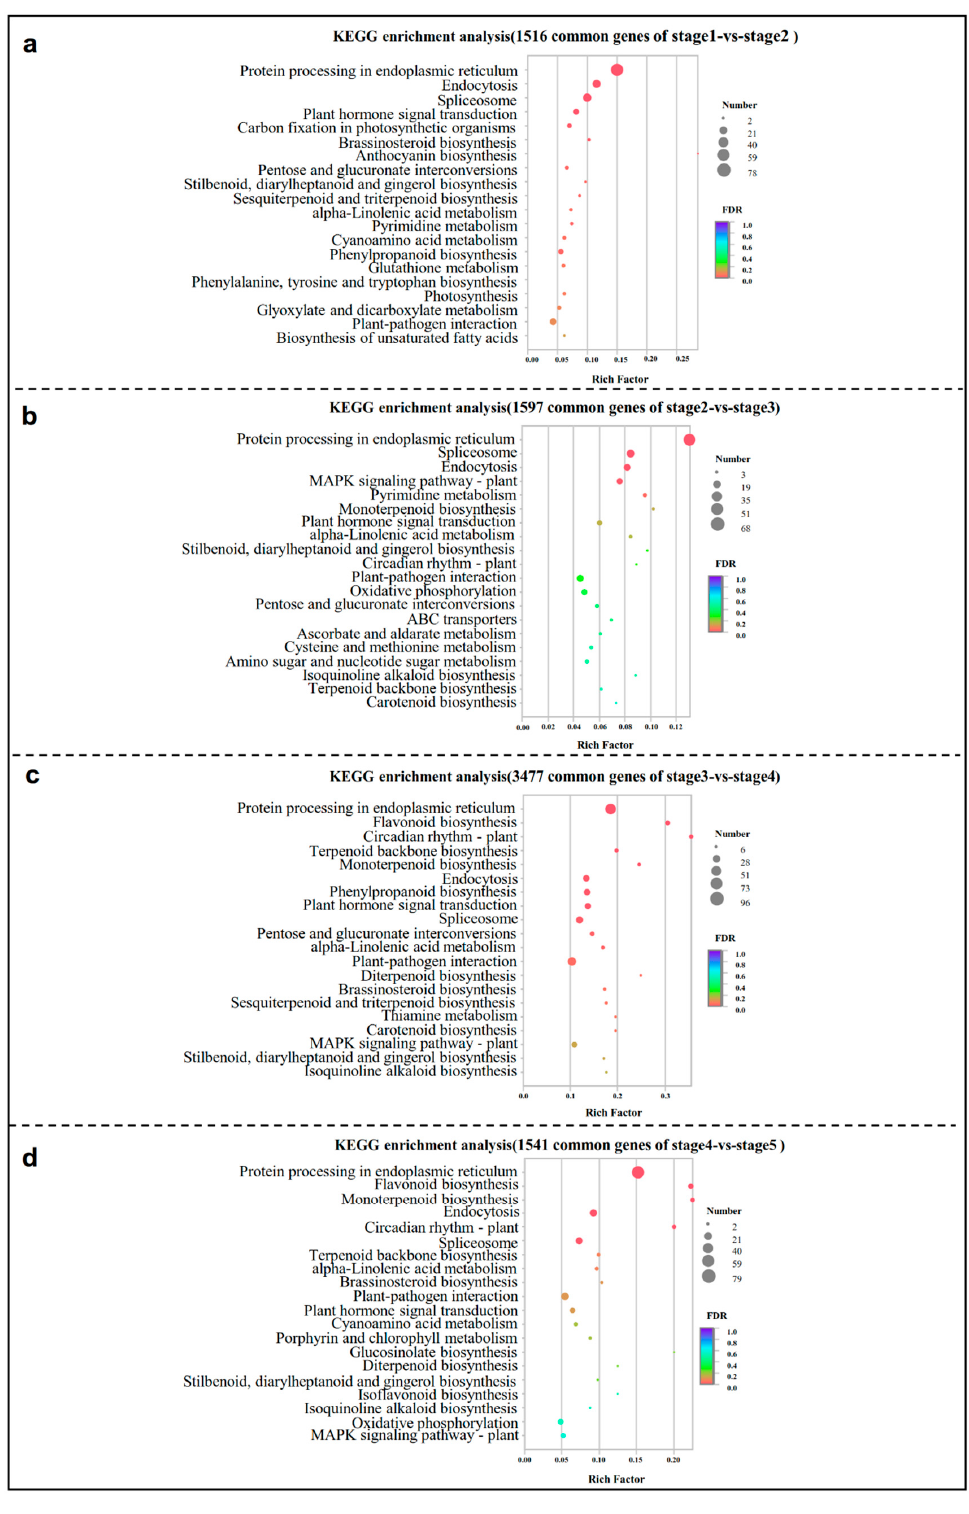
Figure 3. The 20 most enriched KEGG pathway of the common DEGs in stage1 vs stage2 ( a ), stage2 vs stage3 ( b ), stage3 vs stage4 ( c ), and stage4 vs stage5 ( d ). The rich factor represents the ratio of the number of DEGs involved in the pathway to the total number of annotated unigenes in this path- way .